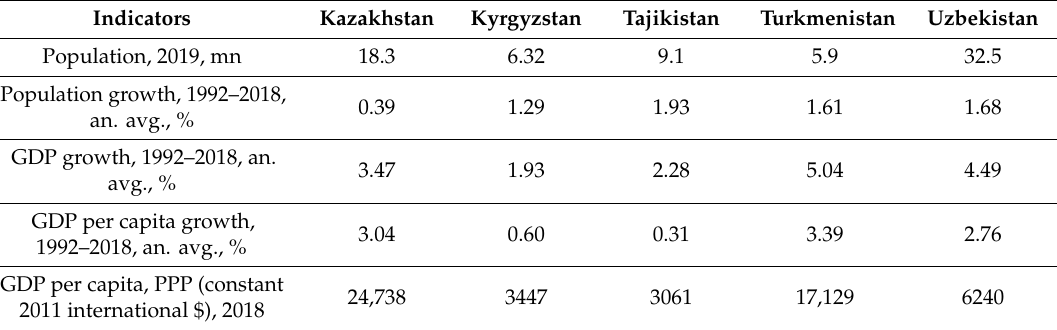
Table 2. Central Asian Economies’ Profiles (Source: author, based on World Bank data).